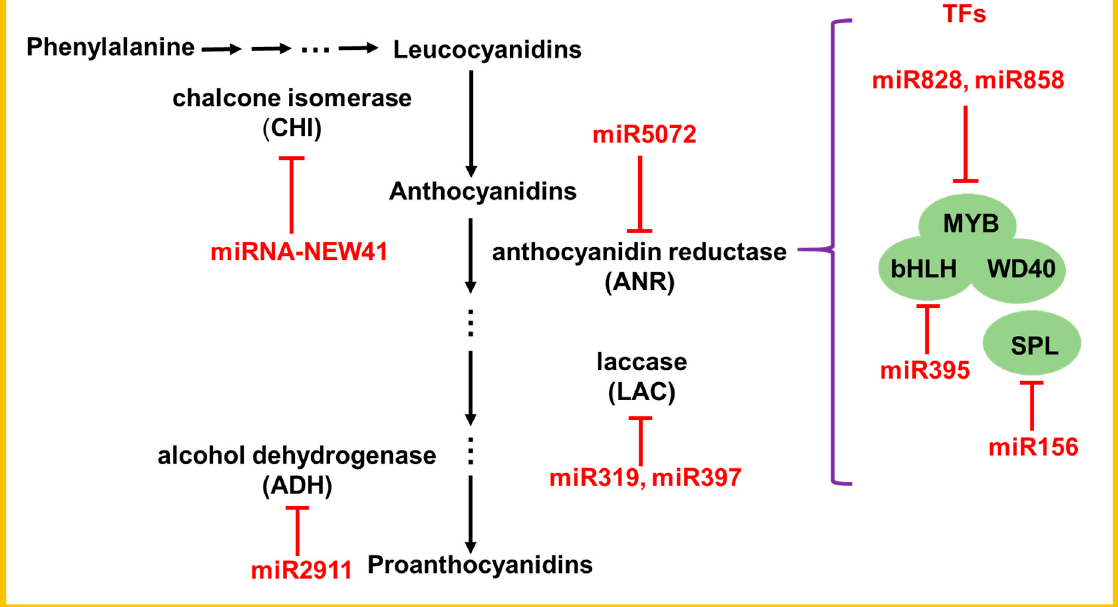
Figure 4. Schematic representation of the core flavonoid anthocyanin pathway leading to major branches of proanthocyanidin biosynthesis and their possible interaction with miRNAs.